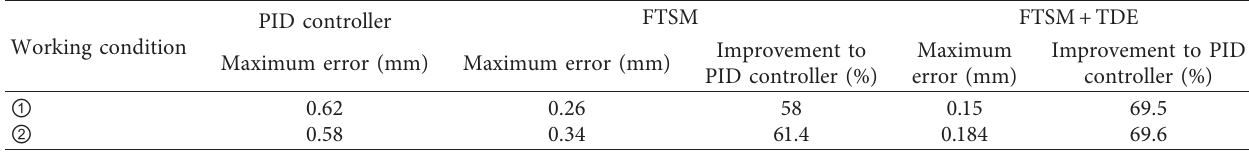
Table 7: Position error under different